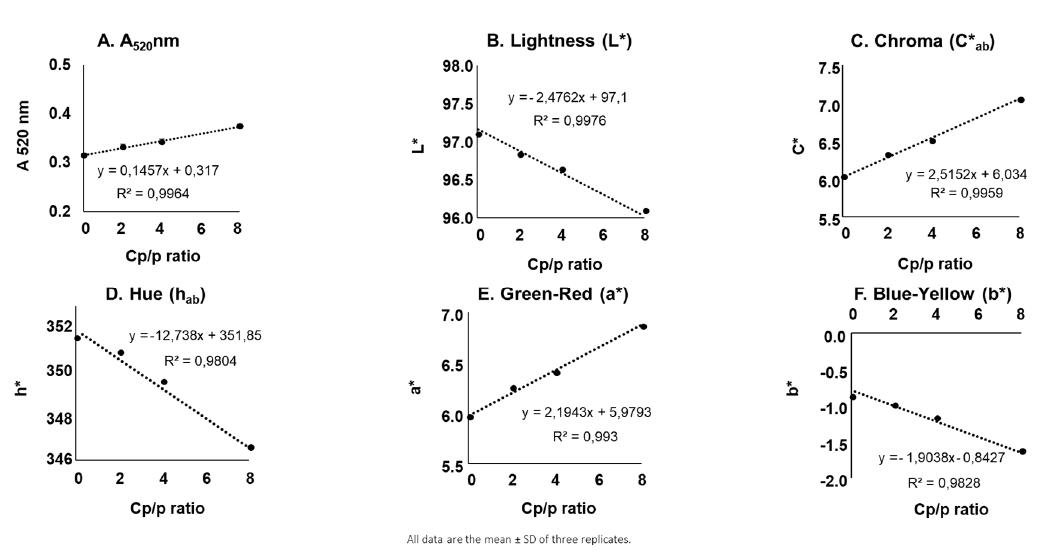
7 of 14 Figure 3. Plot of principal components analysis of model wine solutions of malvidin-3- O -glucoside (50 mg/L) supplemented by increasing concentrations of ( − )-epicatechin and oenological tannins after one week of storage. Various authors have commented on the influence of the intrinsic conditions of red wine, specifically pH level [23,24] and ethanol content [17,25,26], on color stabilization. For this purpose, studies with five of the thirty-six oenological tannins (to represent the different botanical origins) at different pH levels and ethanol content have been performed to confirm the previous results (Figures 1–3).